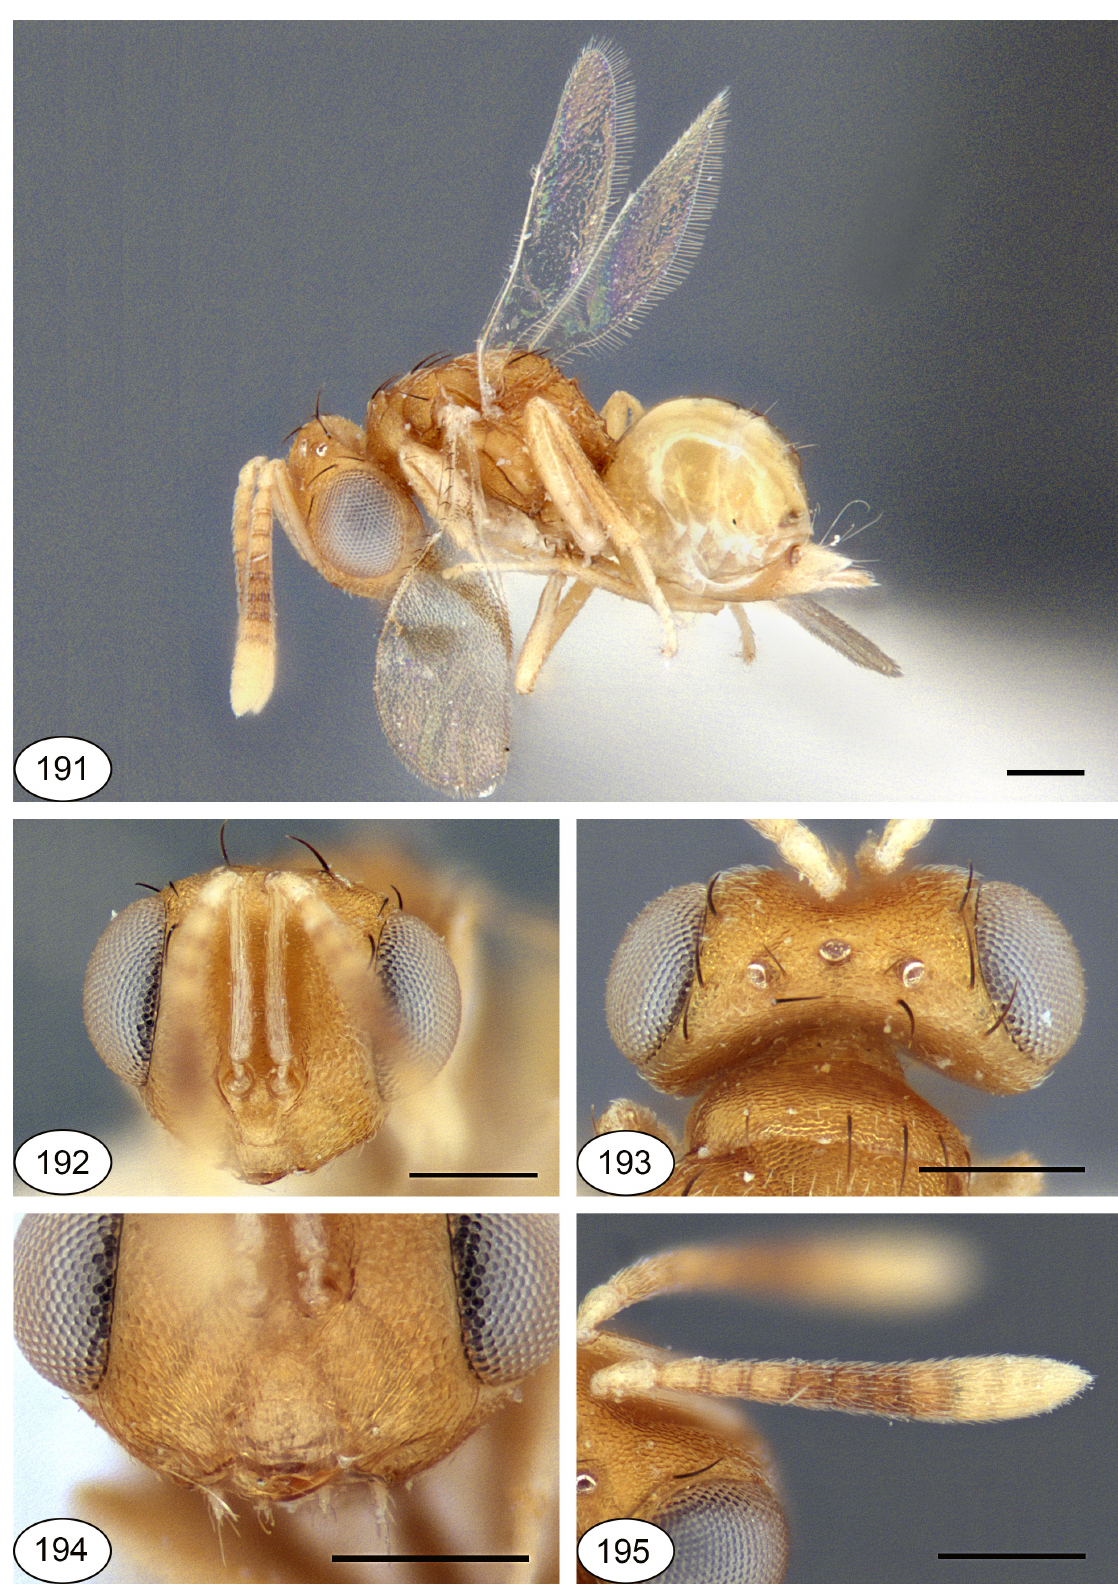
Figs 191–195. Netomocera virgata sp. nov., holotype, ♀. 191 . Habitus, lateral view. 192 . Head, frontal view. 193 . Head, dorsal view. 194 . Lower face. 195 . Antenna. Scale bars: 0.2